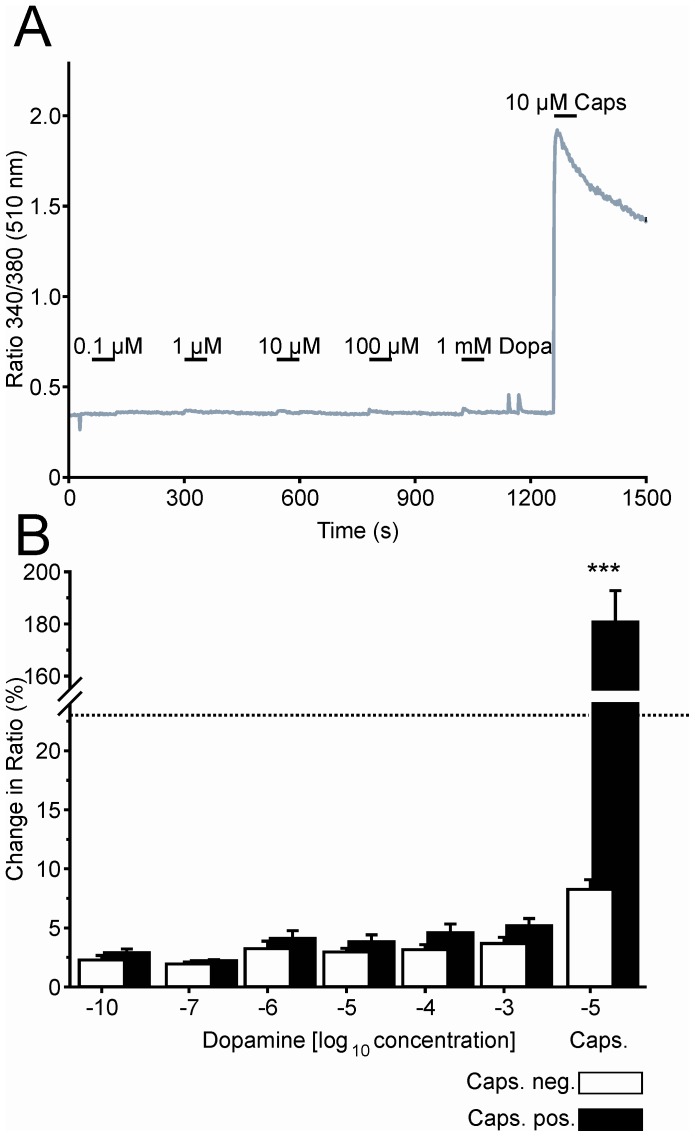
Dopamine does not activate capsaicin-sensitive DRG neurons.
A. Representative examples of calcium imaging experiment using a capsaicin-sensitive DRG neuron challenged with increasing doses of dopamine (0.1–1000 µM). B. Neurons were separated in capsaicin-sensitive (black) and capsaicin-insensitive neurons (open bars). The threshold for a significant response is indicated by the dotted line. 595 excitable neurons investigated in 8 independent experiments (***p<0.001 Capsaicin-sensitive versus –insensitive neurons, student’s unpaired t-test).